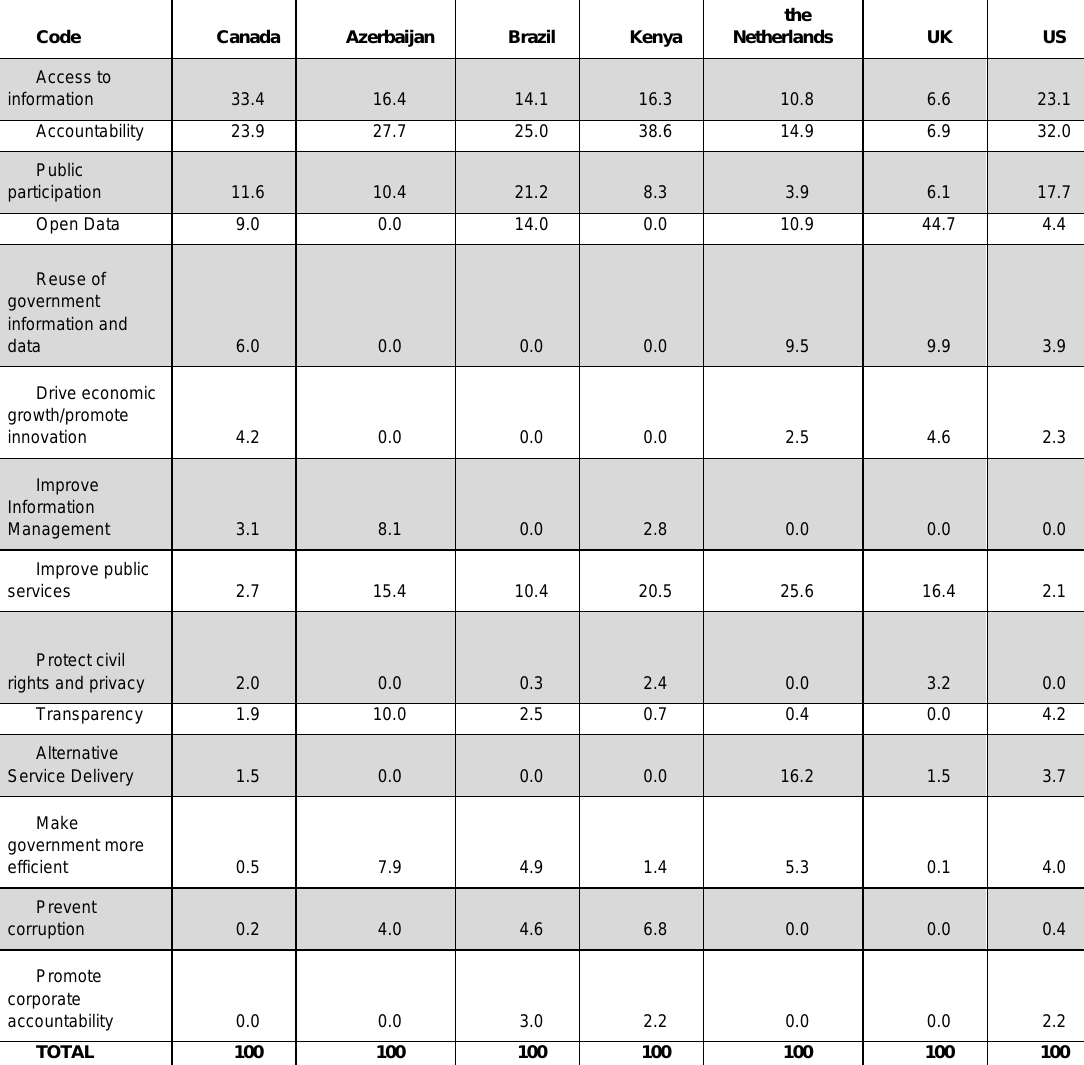
Table 2: Salience of codes by country Action Plans (measured as per cent of total coded words)